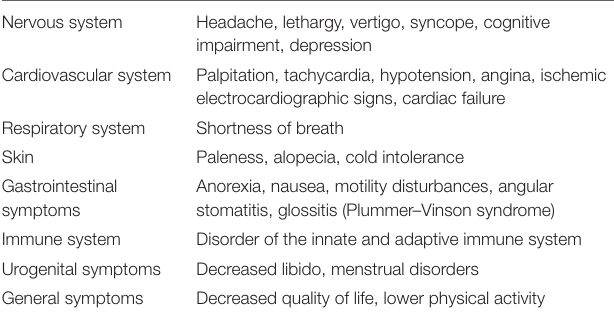
TABLE 1 | Symptoms of iron deficiency anemia.